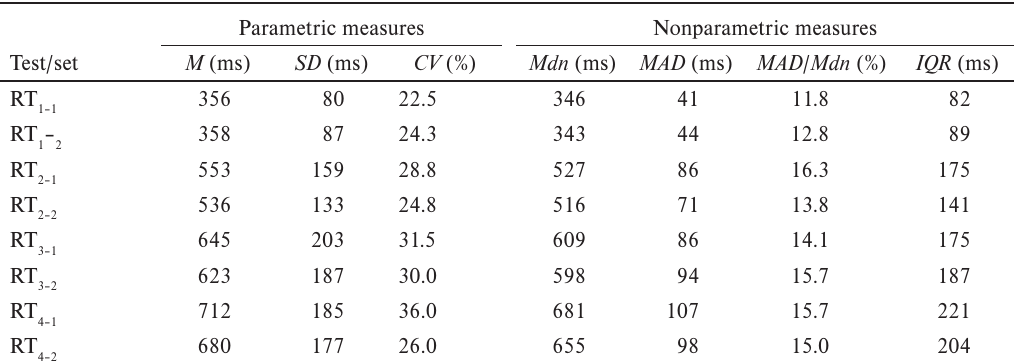
The parametric and nonparametric measures of reaction times (RTs) of all the group achieved in the 1 st and 2 nd series of twenty reaction trials (calculated from 500 RTs; 25 subjects × 20 trials) in the RT RT , RT and RT 2 3 4